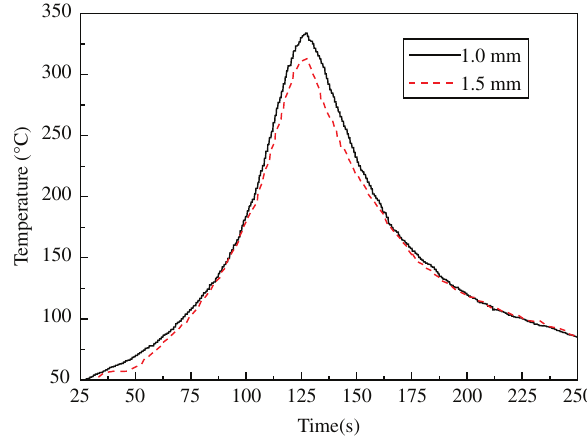
Figure 5: Temperature profiles under the widths of 1 and 1.5 mm.